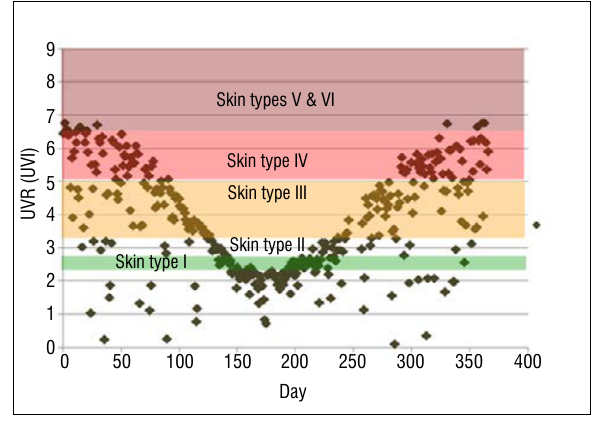
Sunburn thresholds over Pretoria in 2012 for various skin types using 84.11% of the solar ultraviolet radiation (UVR) measured as an ultraviolet index (UVI).